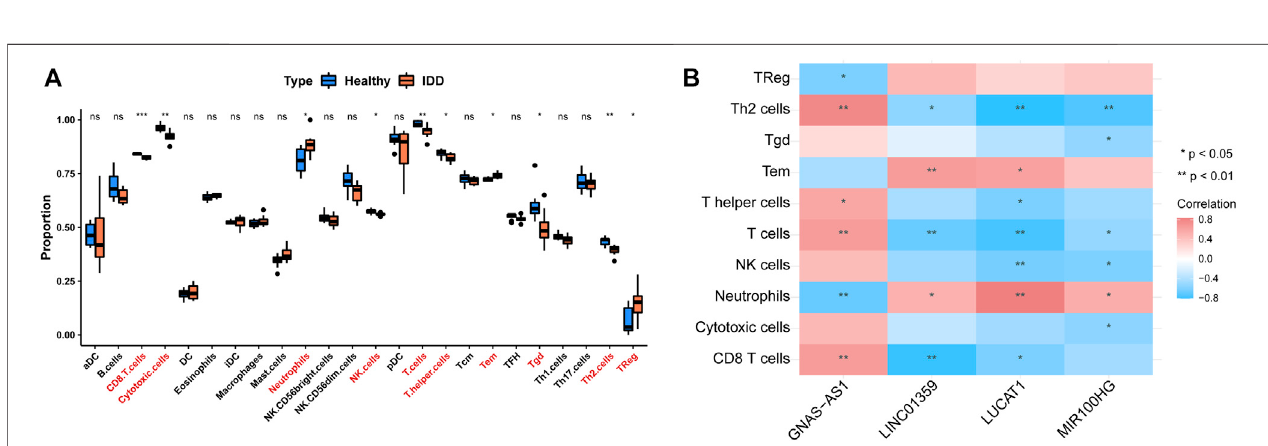
FIGURE 9 | Single sample GSEA and Pearson correlation analysis of immune in fi ltrating cells. (A) The proportion of immune in fi ltrating cells in IDD and healthy group. (B) The correlation of the above 10 differentially abundant immune in fi ltrating cells with four key lncRNAs.